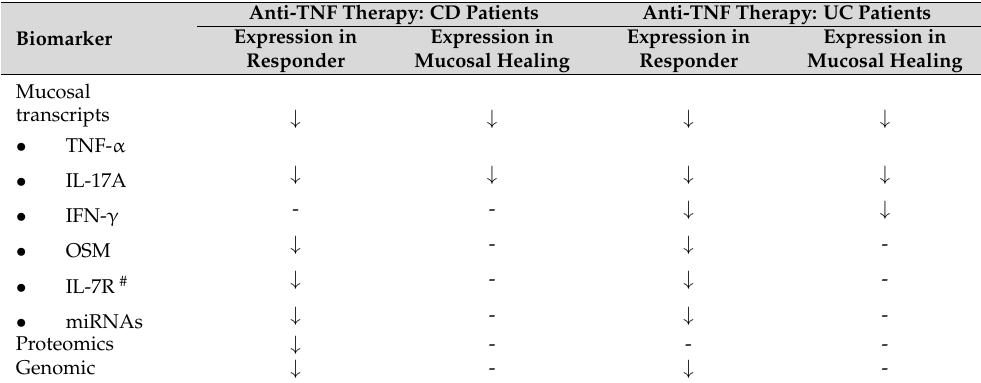
Table 4. Putative biomarkers for evaluating anti-TNF therapeutic efficacy in IBD